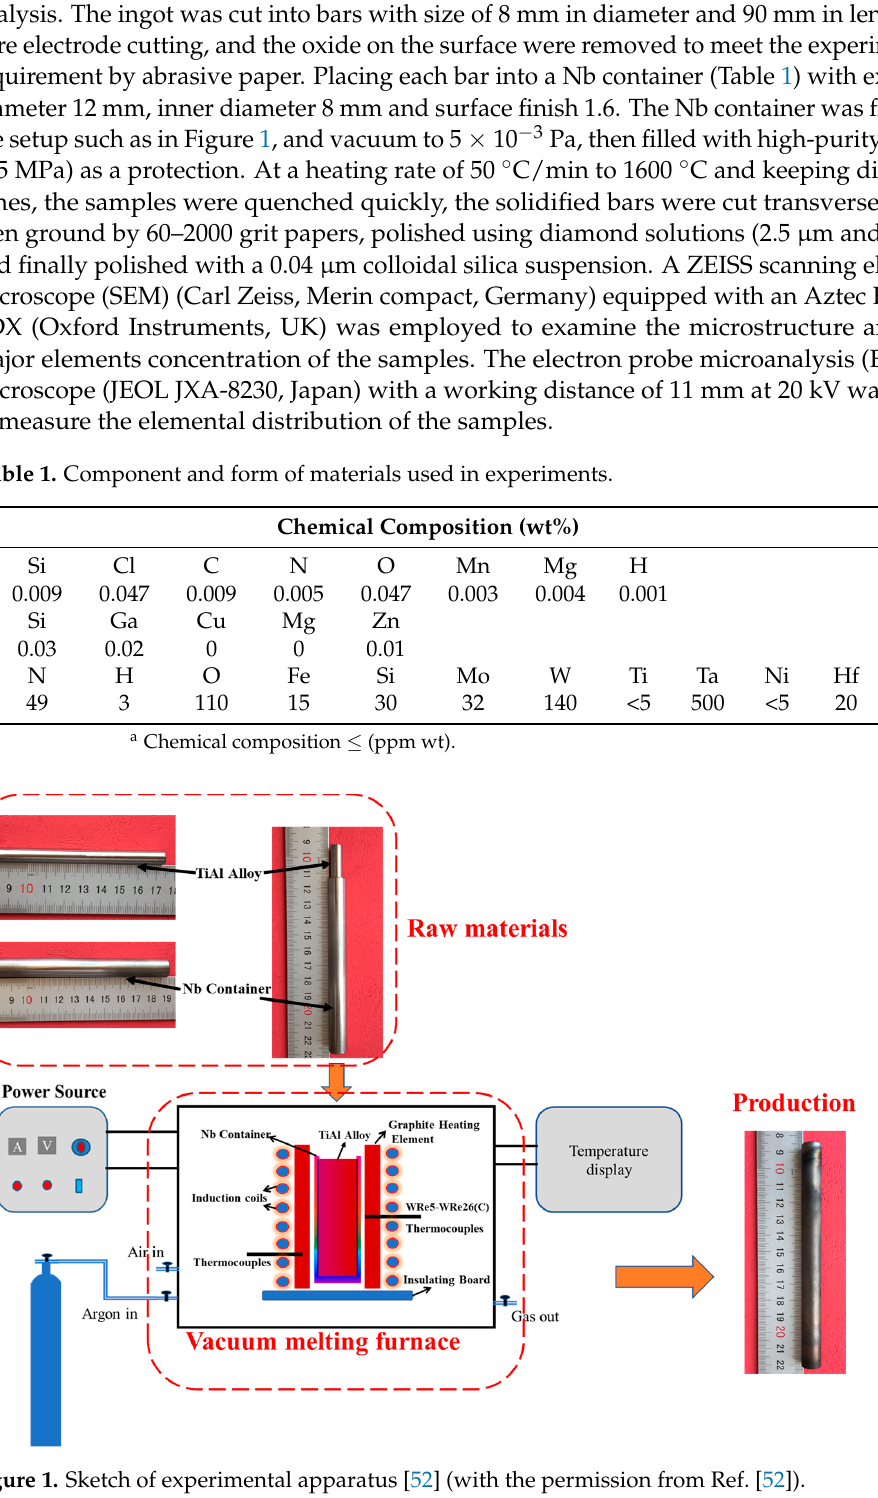
Table 1. Component and form of materials used in experiments.